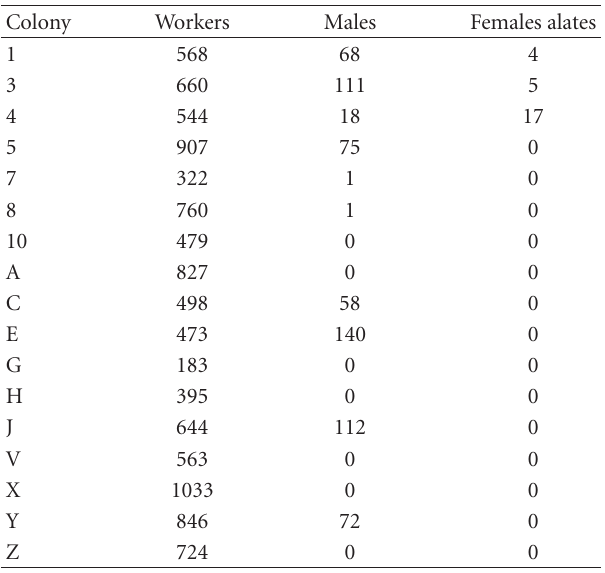
Table 1: Worker number and sexual production for colonies from artificial wooden nests collected in the Mohegan State Forest in August 2003. All colonies except G contained a queen. Colony Workers Males Females